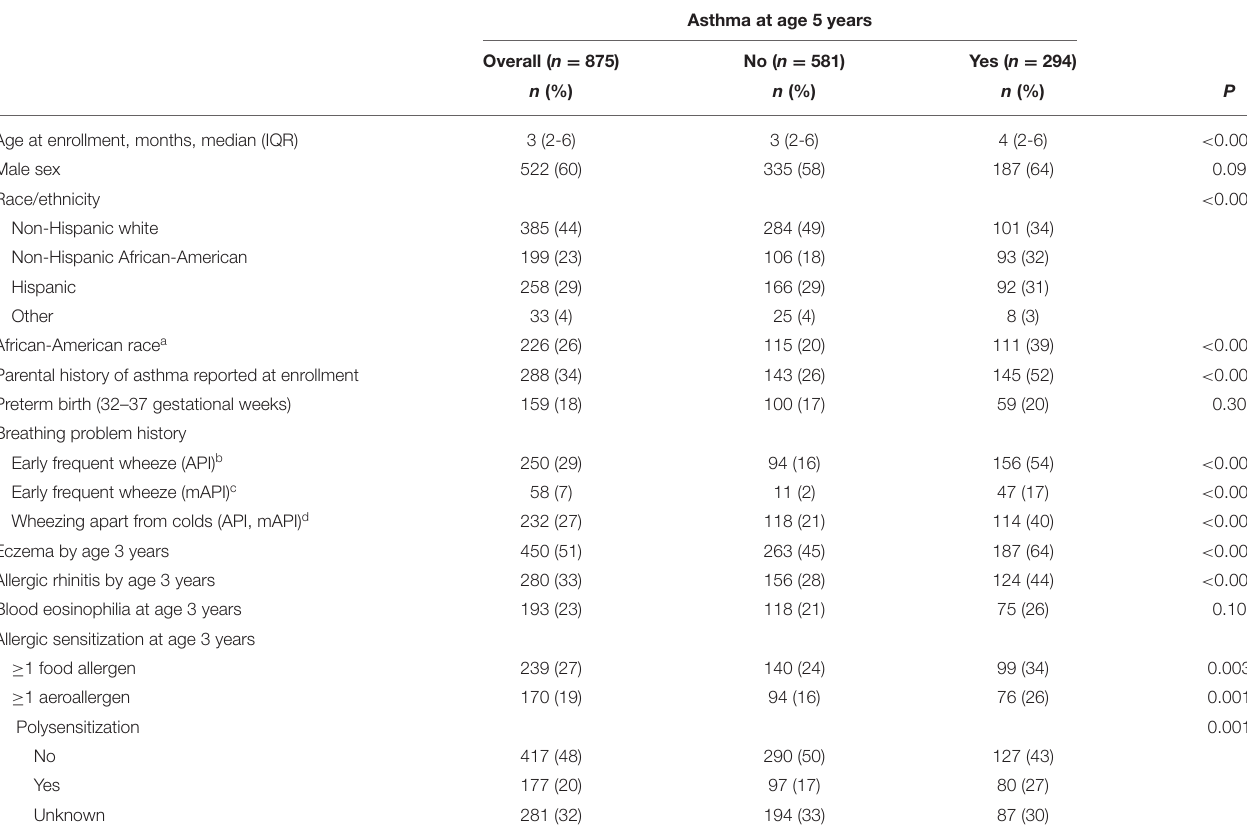
TABLE 1 | Characteristics of children hospitalized for severe bronchiolitis during infancy (MARC-35 cohort), by asthma status at age 5